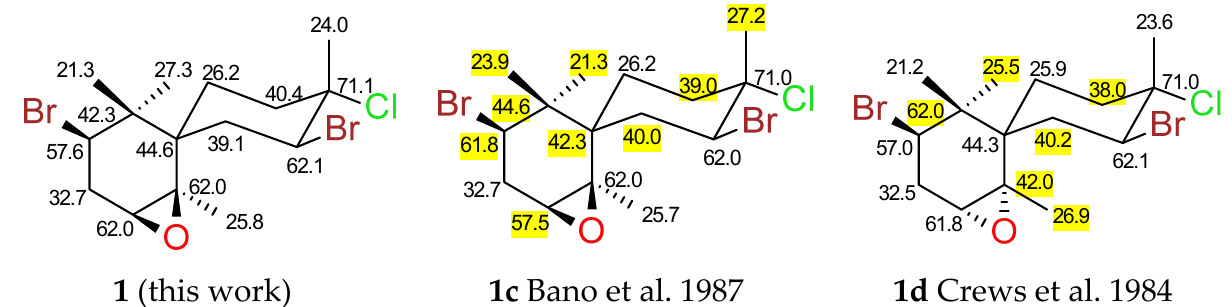
Figure 3. Key NOESY correlations for compound 1 .